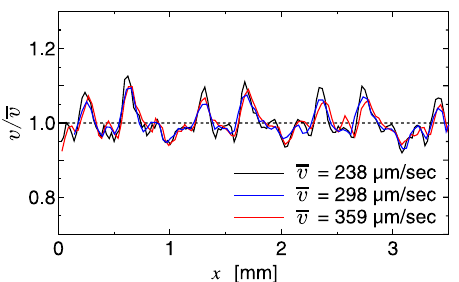
Fig. 5 The relation between the position x of the syringe pump stage and the ratio of the measured stage speed v to the time mean speed v .